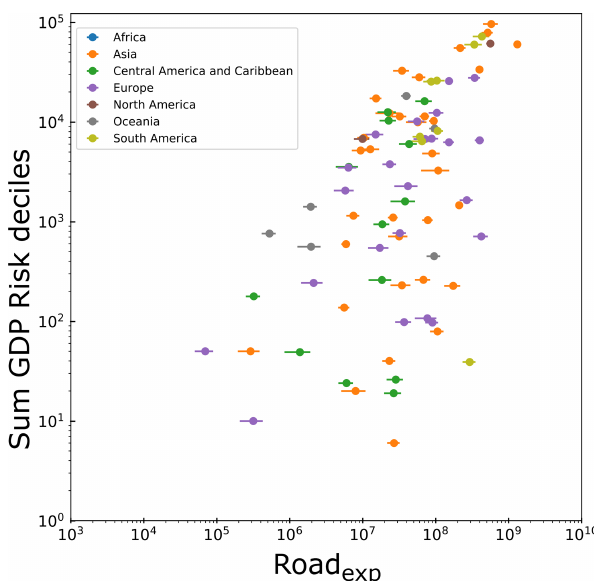
Figure 6. Plotting the exposure of roads (in units of sum of nowcasts multiplied by kilometre of road per year for each country) against the estimated GDP cost of landslide impact estimated by Dilley et al. (2005).